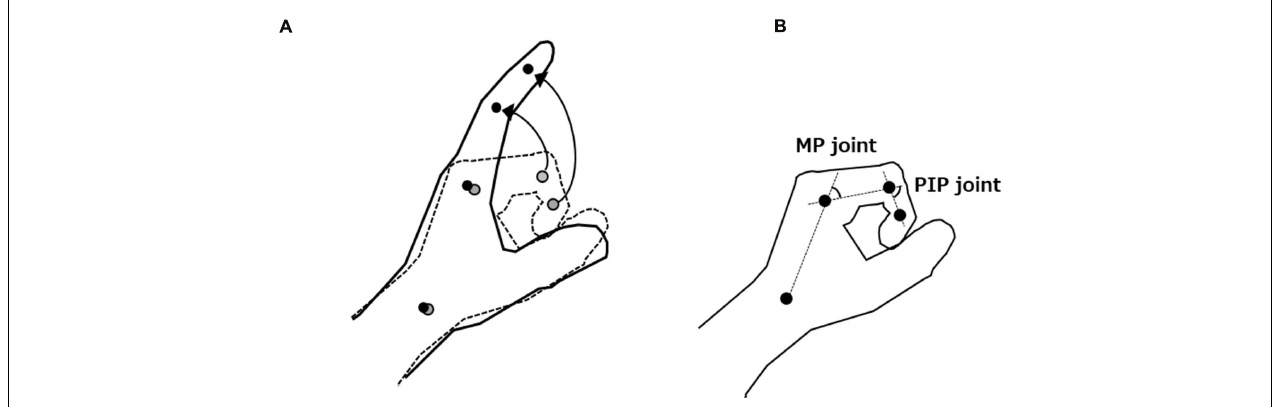
FIGURE 2 | (A) Motor task and trajectories of the reflective markers. (B) Measurement of flexion angle of the proximal interphalangeal (PIP) and metacarpophalangeal (MP) joints. We defined the active range of PIP and MP joint extension as the difference between each joint’s maximum finger flexion and extension angles.